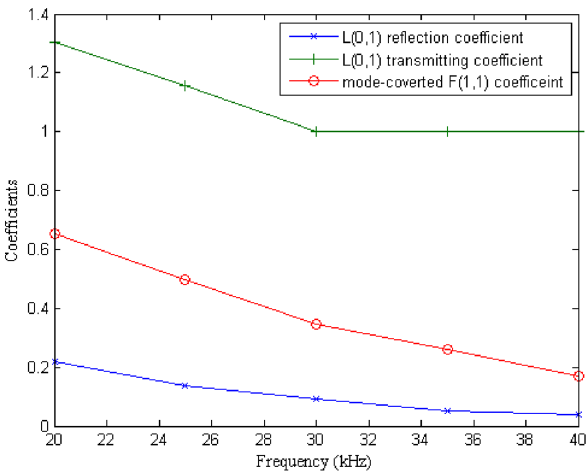
Figure 6. Evolution of the coefficients with respect to